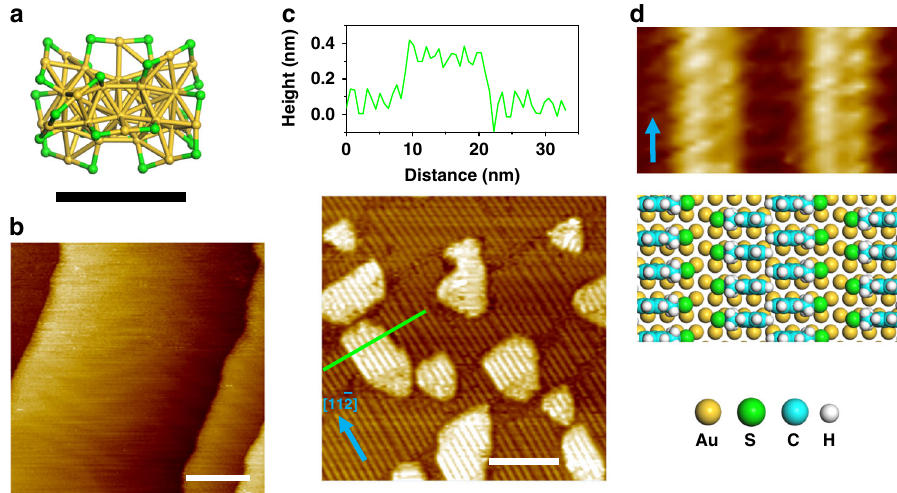
Fig. 2 Atomic layer deposition at the liquid-metal interface. a Structure of the left-handed enantiomer of Au 38 (SCH 2 CH 2 Ph) 24 . For clarity, the phenylethyl groups are not displayed and a scale bar is used to illustrate the size of the cluster. b Representative STM image of a clean Au(111) surface. c STM image of the surface morphology upon the deposition of a 1,2,4-trichlorobenzene (TCB) solution of ( rac )-Au 38 ( C = 5 µ M) onto the Au(111) surface ( I set = 130 pA, V = − 900 mV). Height pro fi le along the green line is displayed on the top. d Close-up STM image (1.4 × 2.5 nm 2 ) and structural model of the pin-stripe (cid:1) (cid:3) bias phase of 2-phenylethanethiol. Equivalent 11 (cid:1) 2 directions of the underlying Au(111) surface are indicated with blue arrows. Scale bars: a , 1 nm; b , c , 20 nm